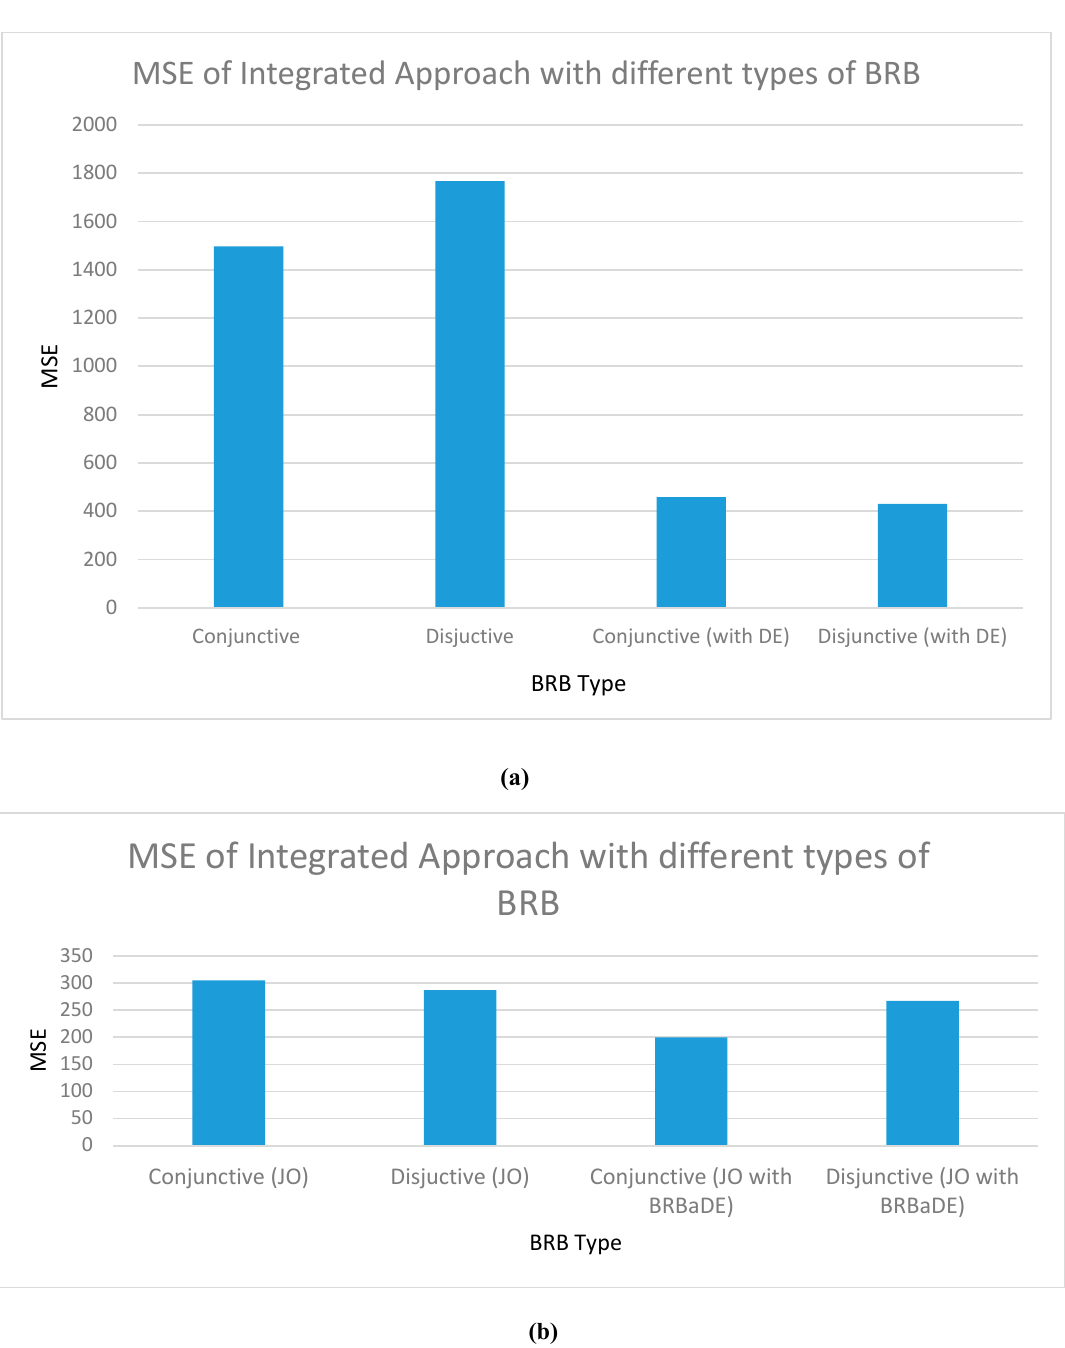
Figure 8. Comparison of results with Receiver Operating Characteristic (ROC) curves.